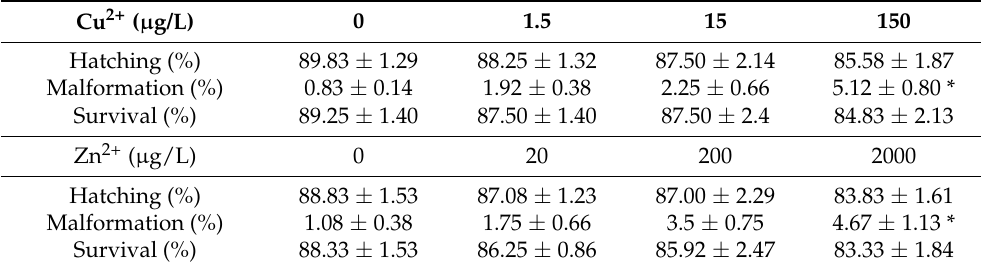
Table 1. The changes of hatching, malformation, and survival rates in zebrafish embryos/larvae treatment with Cu 2+ and Zn 2+ . Data are shown as the mean ± SD ( n = 6). * p < 0.05, denotes a statistically significant difference between the treatment and